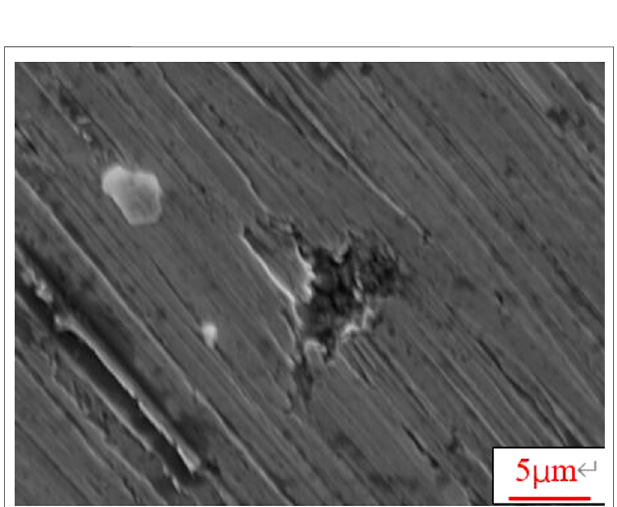
FIGURE 10 | Corrosion pit morphology.